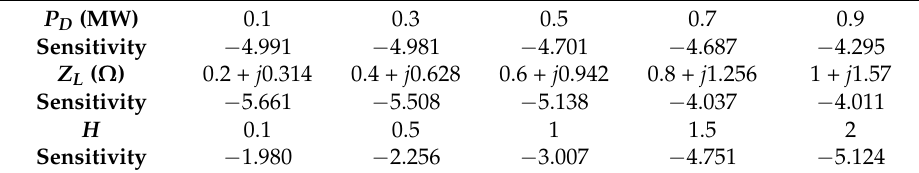
Table 4. Sensitivity of the stability domain area to P D , Z L , and